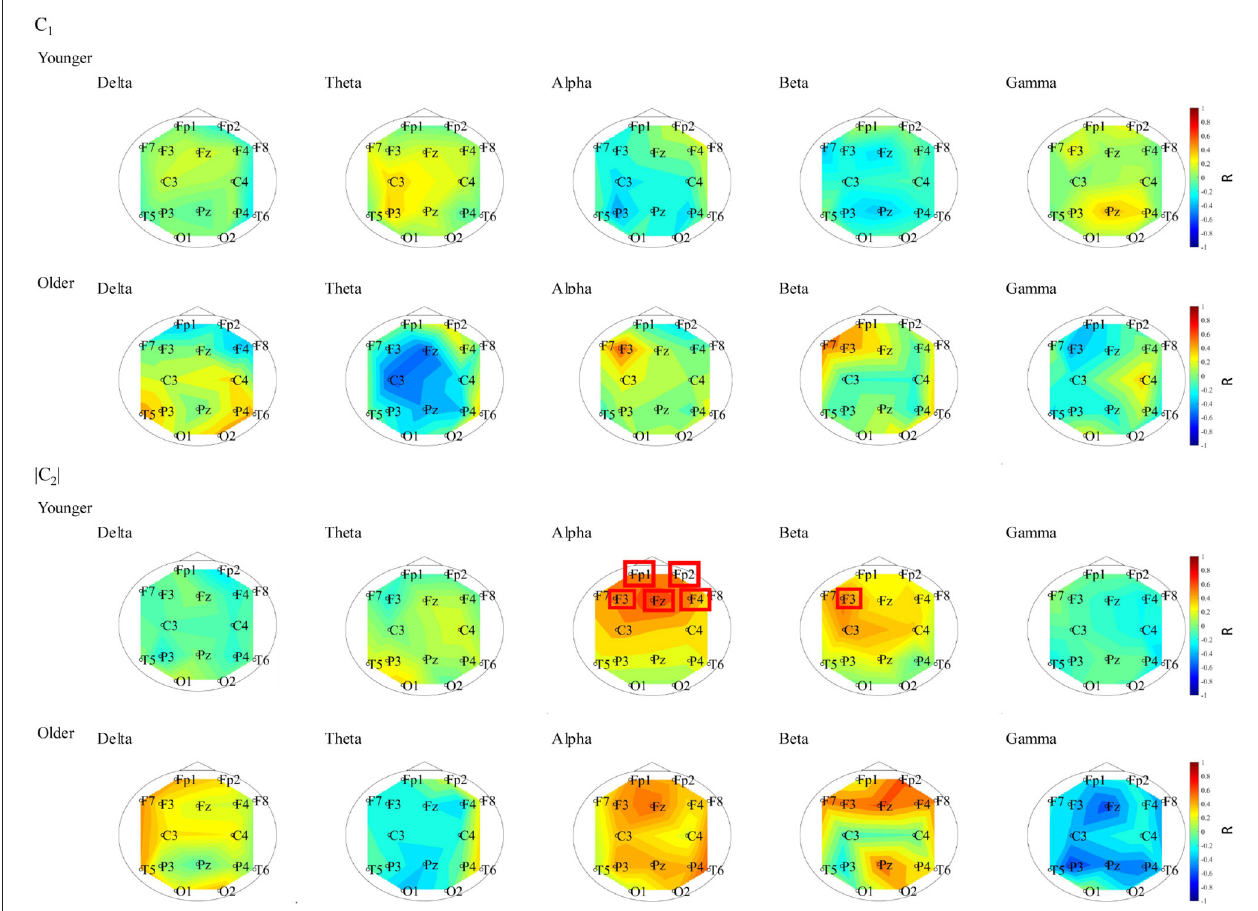
FIGURE 6 | Spearman’s rank correlation coefficient R between NS of PLI and c 1 in younger (1st line) and older (2nd line) groups. The correlation values did not meet the FDR correction criteria of q < 0.050. Spearman’s rank correlation coefficient R between NS of PLI and | c 2 | in younger (3rd line) and older (4th line) groups. The electrodes with correlation values to meet the FDR correction criteria of q < 0.050 are surround with a line. In younger group, positive correlation with NS at alpha and | c 2 | at Fp1, Fp2, F3, F4, and Fz and positive correlation with NS at beta band and | c 2 | at F3 were